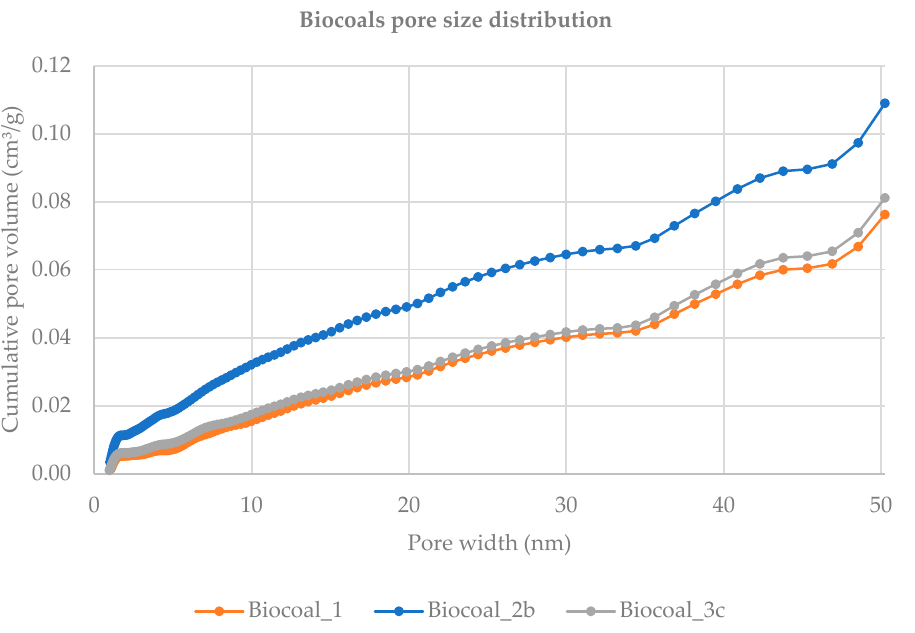
Table 15. Ash extraction efficiency ( AE ) and characterization of the extracted biocoals case 1 (bio- coal 1 ), case 2 (biocoal 2b ), and case 3 (biocoal 3c ). Different letters in the same row indicate significant differences between means for p < 0.05 ( n = 3).